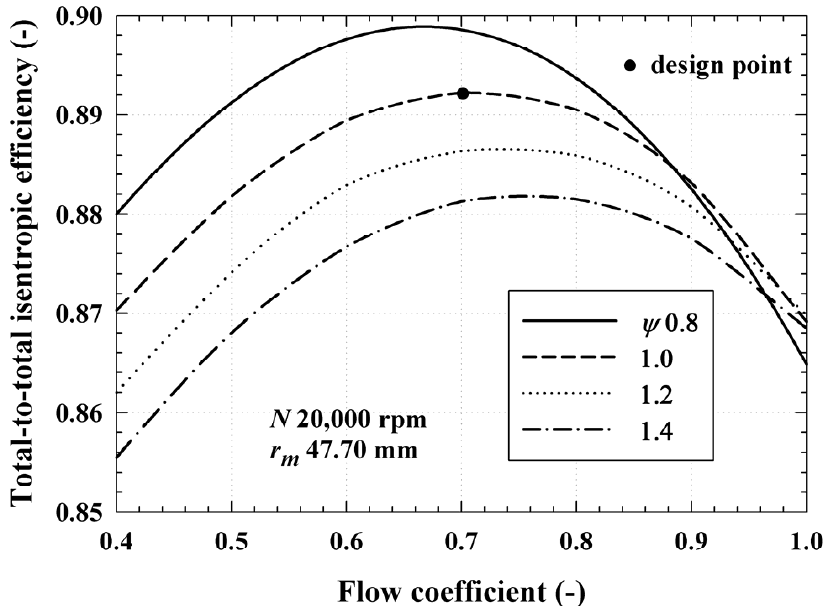
Figure 8. Total-to-total isentropic efficiency of the turbine ( η t ) when the flow coefficient ( ϕ ) ranges from 0.4 to 1.0 and loading coefficient ( ψ ) ranges from 0.8 to 1.4.